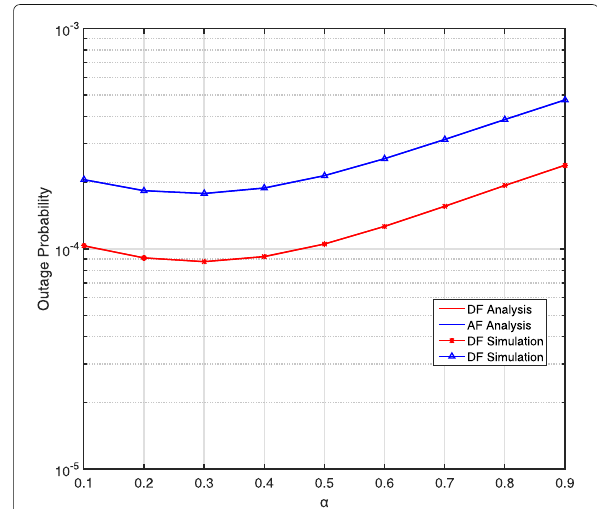
Fig. 2 Outage probability versus E h 1 for ρ with DF